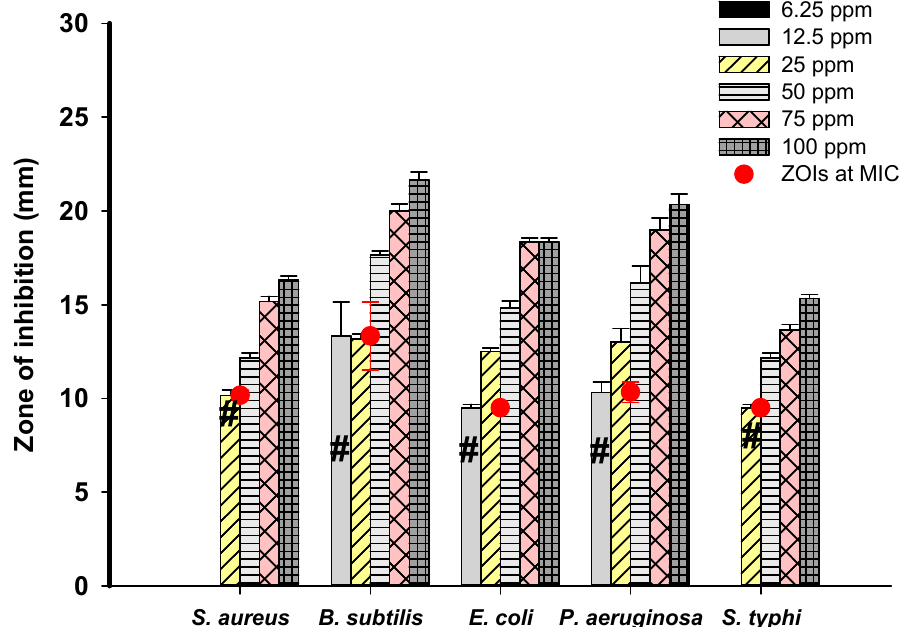
Figure 5. Antibacterial activities and minimum inhibitory concentrations (MICs) for Ag-NPs synthesized by S. antimycoticus L-1 against pathogenic S. aureus, B. subtilis, P. aeruginosa, E. coli, and S. typhimurium. # indicates MIC value.